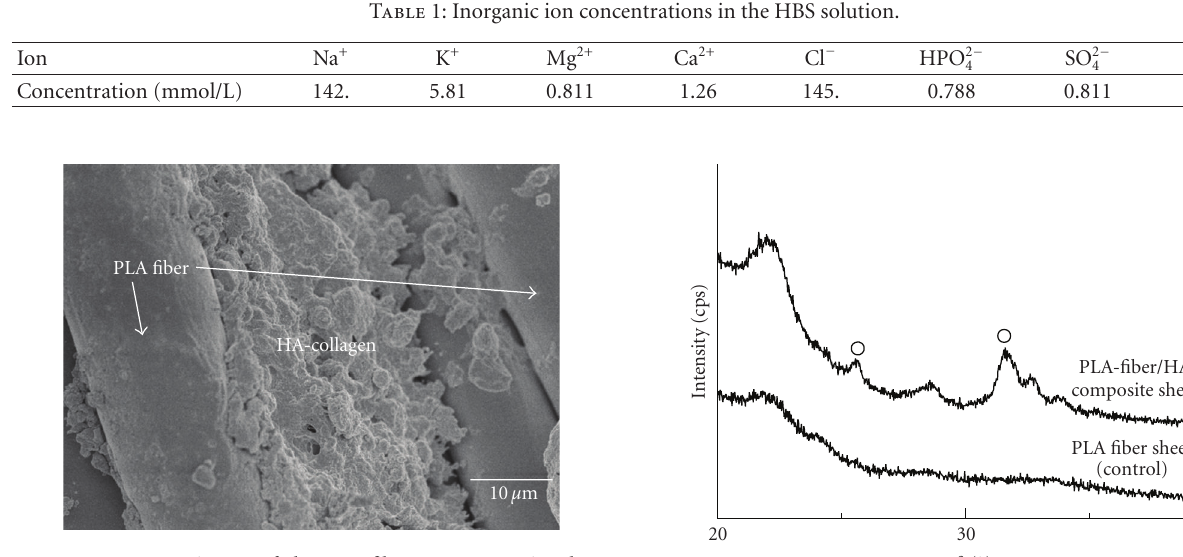
Figure 3: FE-SEM image of the PLA-fiber/HA composite sheet. (Original magnification × 2,000).